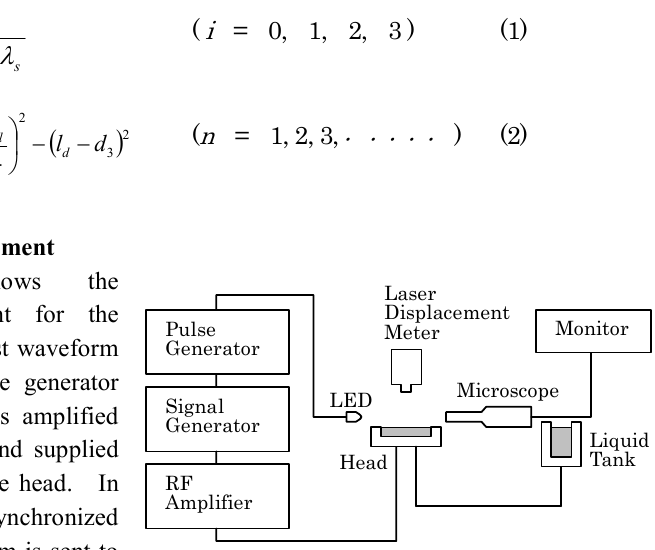
Fig.3 Experimental Drop Observation